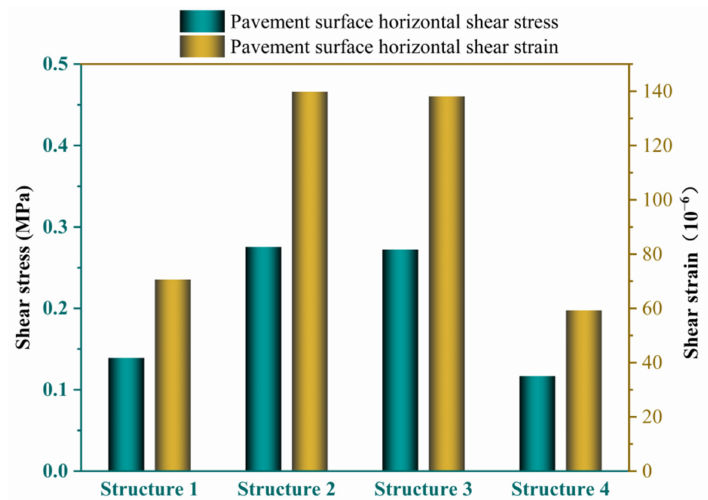
Figure 7. Antipushing performance parameters for pavement structure (in driving